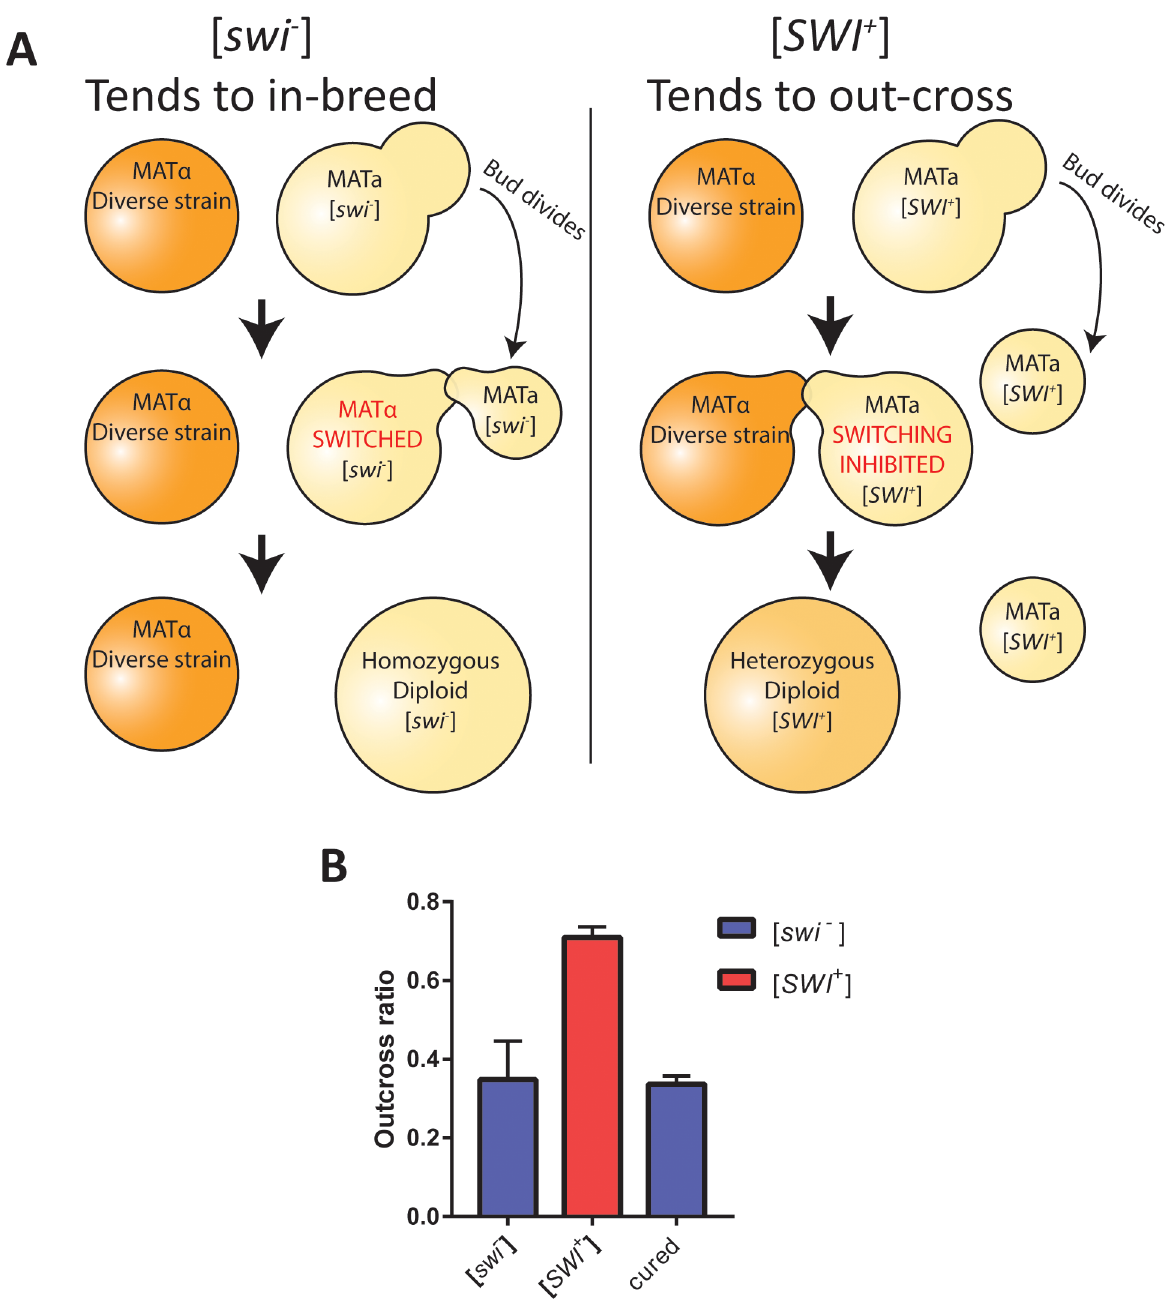
Fig 2. The [ SWI + ] prion encourages diverse mating partners. (A) A diagram showingthe mating tendencies of [ SWI + ] and [ swi − ] haploids(buddingyellow cell). Left: A [ swi − ] cell will readily switch its mating type after dividingand mate with its own daughter. The resultingdiploidcannot out-cross with diversemating partners (orangecell). Right: In the [ SWI + ] pioneeringstate, mating-type switchingis inhibited,and thus mother cells cannot mate with their own daughters. This increasesthe likelihood that they will mate with geneticallydiversepartners. Note that after normal mating-typeswitching, an additionalgenerationmay occur before mating, after which the four haploidsinvolvedcan mate in pairs (not depicted). (B) Relativeout-crossing efficienciesof [ swi − ] cells (blue) and [ SWI + ] cells (red). Eliminationof the prion from the [ SWI + ] strain (“cured”) returns its out-cross ratio to the low state. The ratio was calculatedby normalizingto the mating efficiencyof ho − control cells (S2A Fig). Error bars indicatestandard deviation( n = 3). Numerical data and the flow cytometry gating strategy are availablefrom the Dryad Digital Repository: http://dx.doi.org/10.5061/dryad.d5r16.